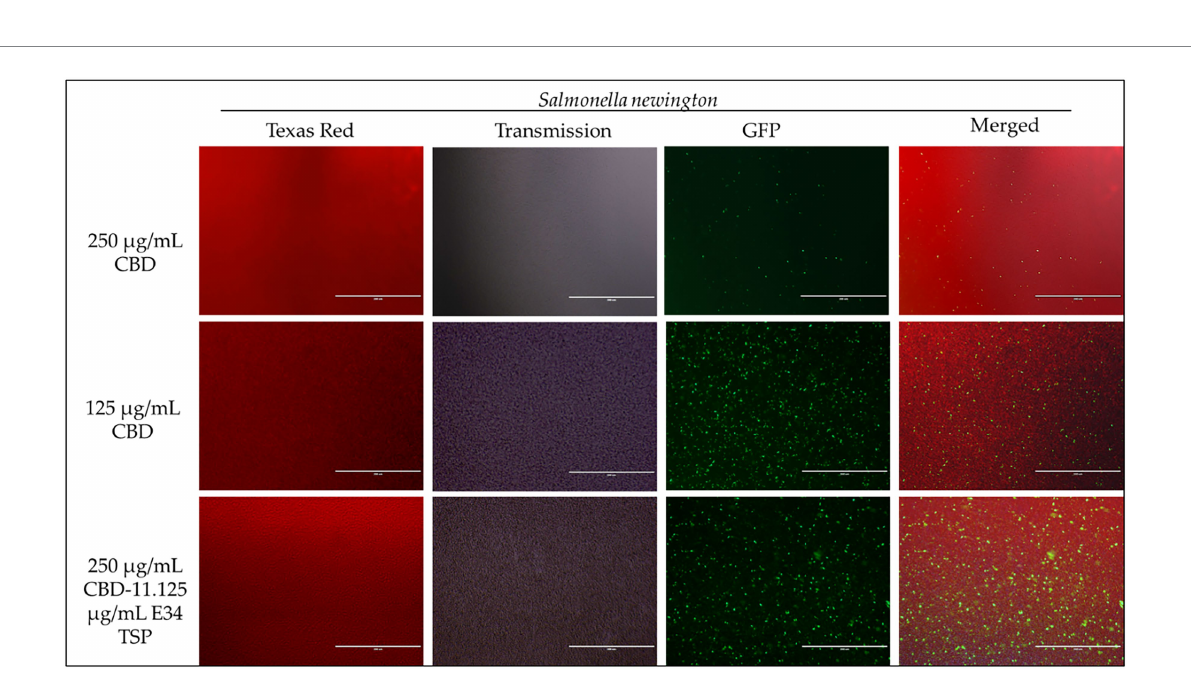
S . Newington. E34 TSP demonstrated both time and dose dependent inhibition of S . Typhimurium (Figure 10B). As expected, CBD extract failed to show any significant inhibition of S . Newington in all treatments (Figure 10C). Treatment of